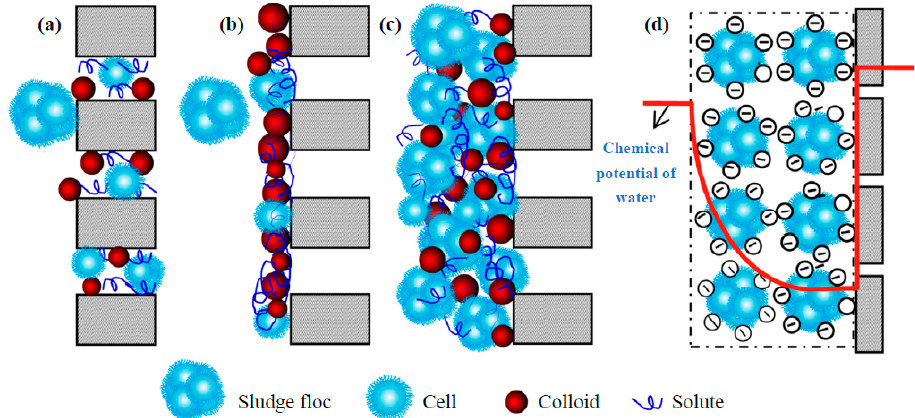
Figure 2. Schematic illustration of some membrane fouling mechanisms: ( a ) pore clogging, ( b ) gel layer formation, ( c ) cake layer formation, and ( d ) osmotic pressure effect [3].